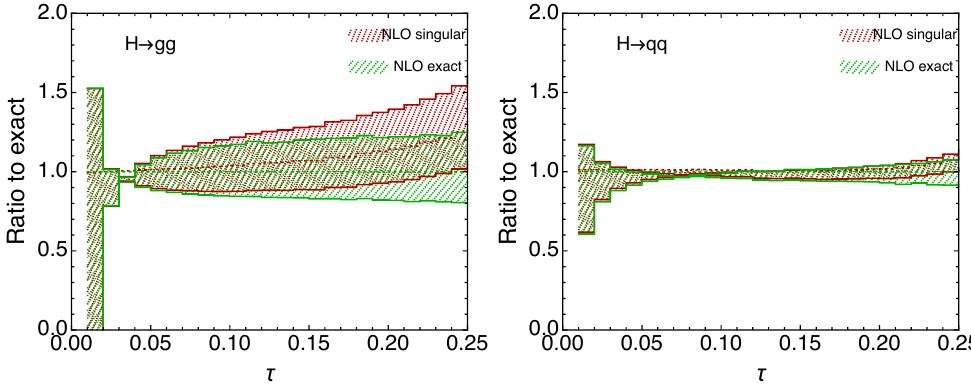
Figure 7 . Comparison between the exact results and the singular terms at